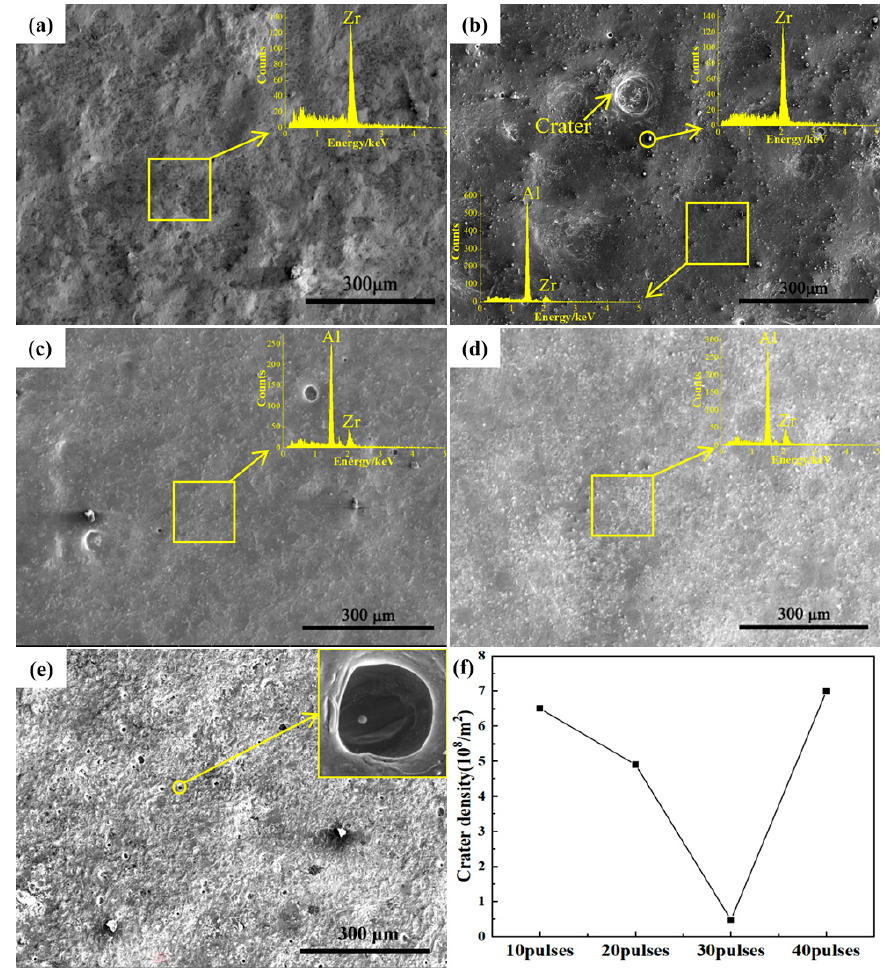
Figure 2. Surface SEM images of samples before and after HCPEB irradiation: ( a ) milled samples, ( b ) 10 pulses, ( c ) 20 pulses, ( d ) 30 pulses, ( e ) 40 pulses, and ( f ) crater density of different pulses.